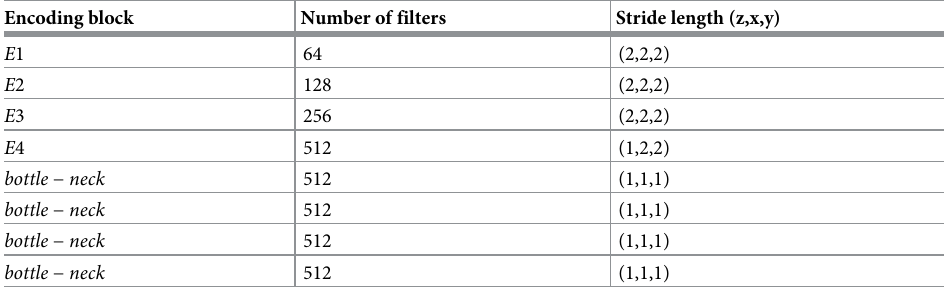
Table 4. The number of filters and stride lengths that were used in the Vox2Vox GAN’s encoding blocks. Encoding block